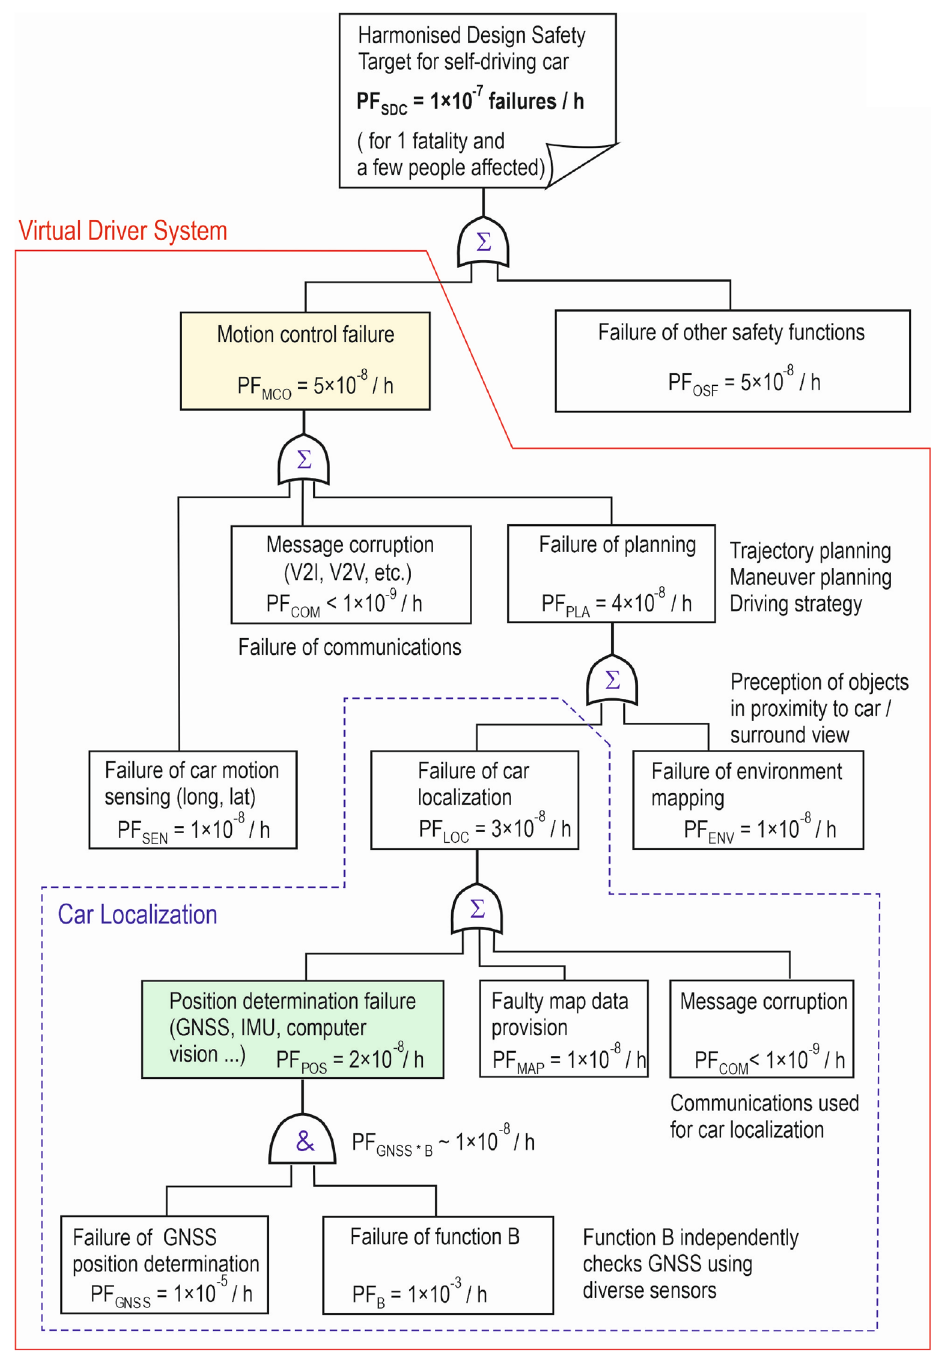
Figure 6. Example of fault tree with allocation of safety target to main SDC